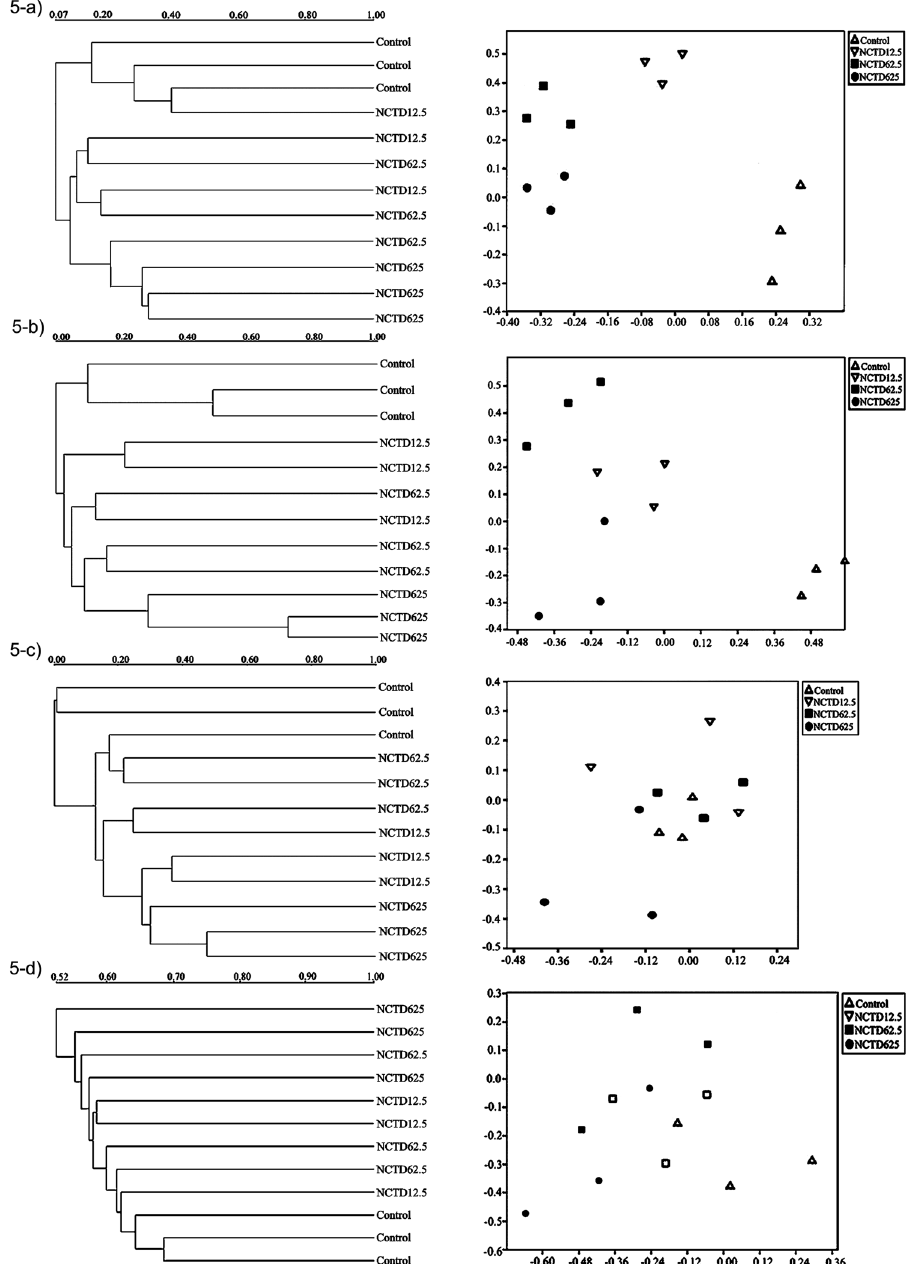
Figure 5. UPGMA and nMDS analyses of 18S rRNA gene from soil fungus. ( a – d ) Norcantharidin (12.5, 62.5 and 625 mg kg − 1 DW soil) treated samples and control at different incubation times ( a , 3 days; b , 7 days; c , 15 days and d , 35